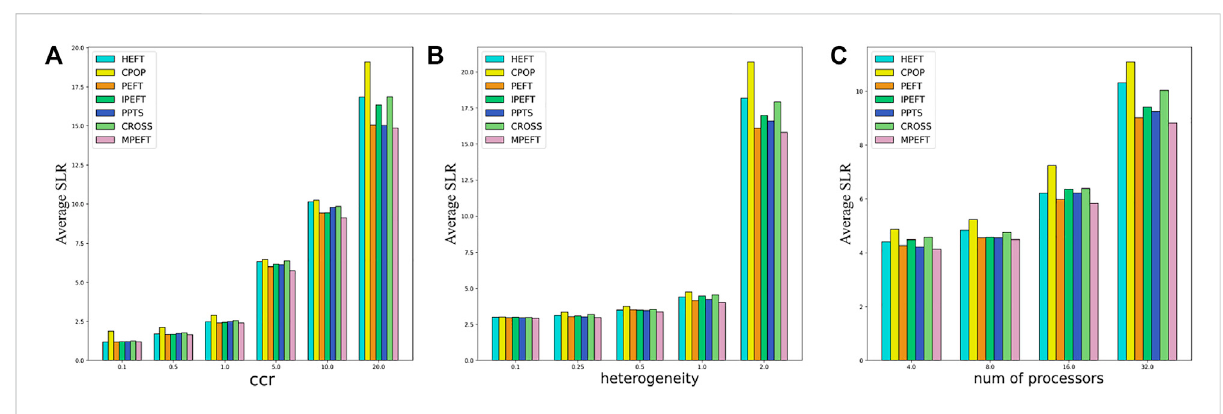
FIGURE 13 Average SLR as function of ccr (A) , heterogeneity (B) and number of processors (C) for Molecular Dynamics Work fl